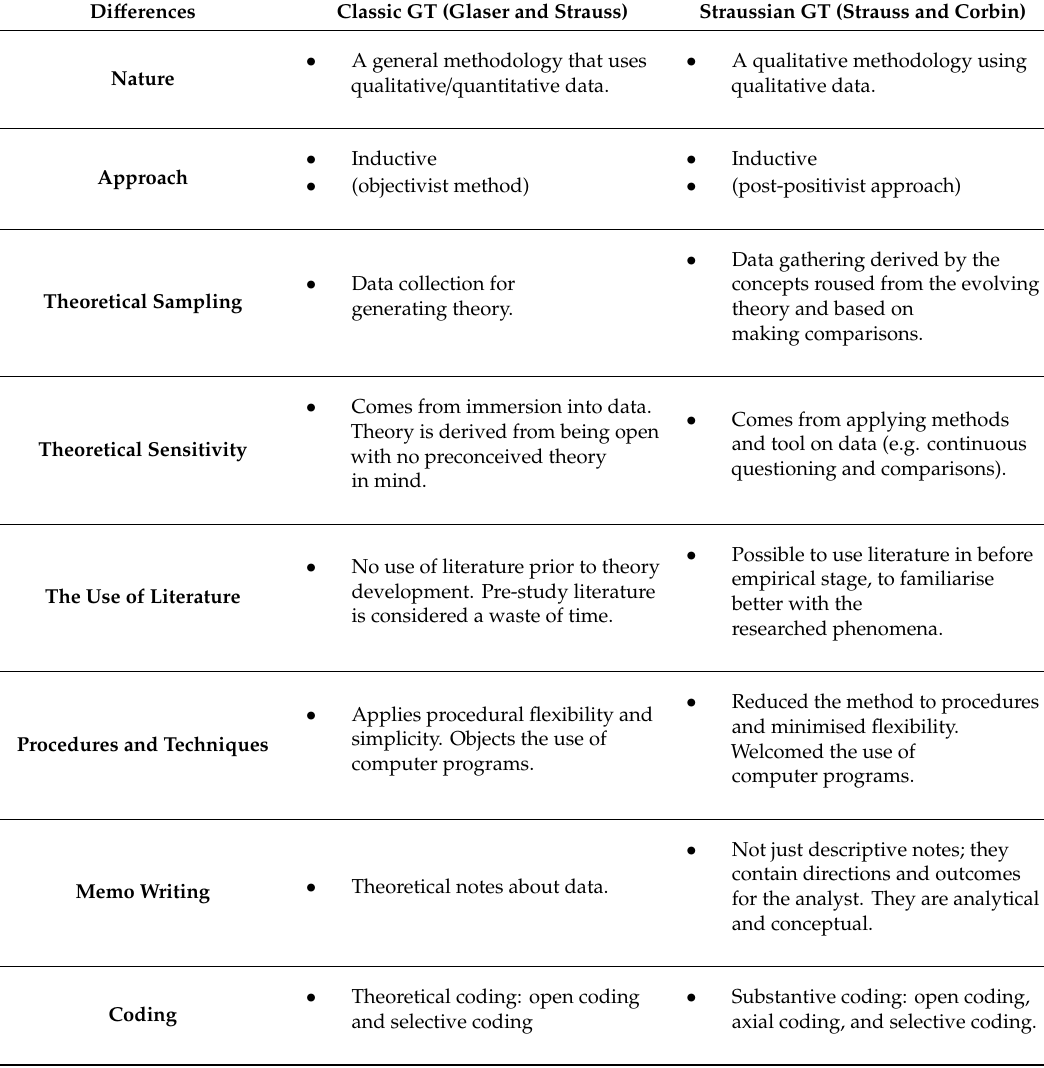
Table 1. Di ff erences between classic GT and Straussian GT versions (Allen and Davey 2018). Di ff